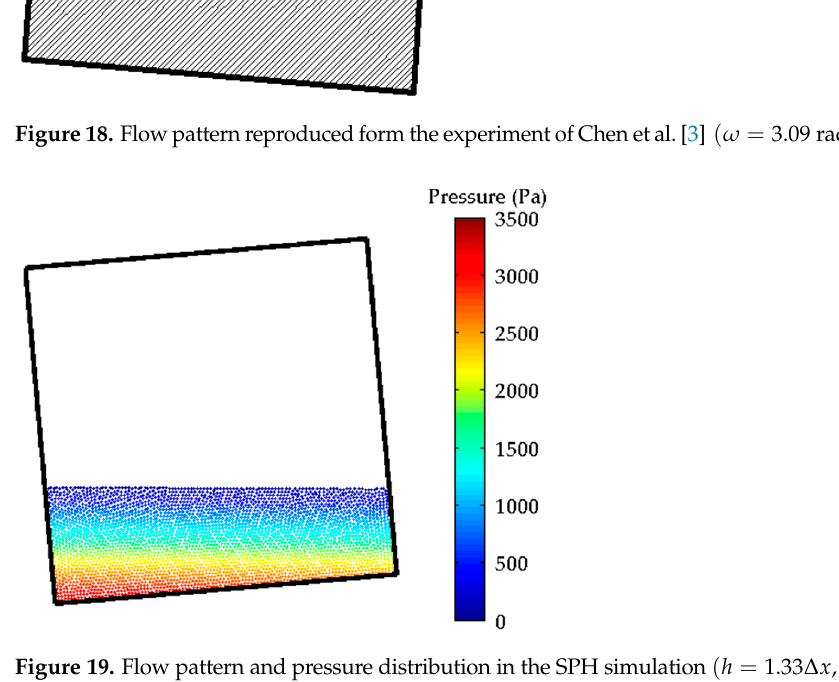
Figure 20. Flow pattern and pressure distribution in the SPH simulation (